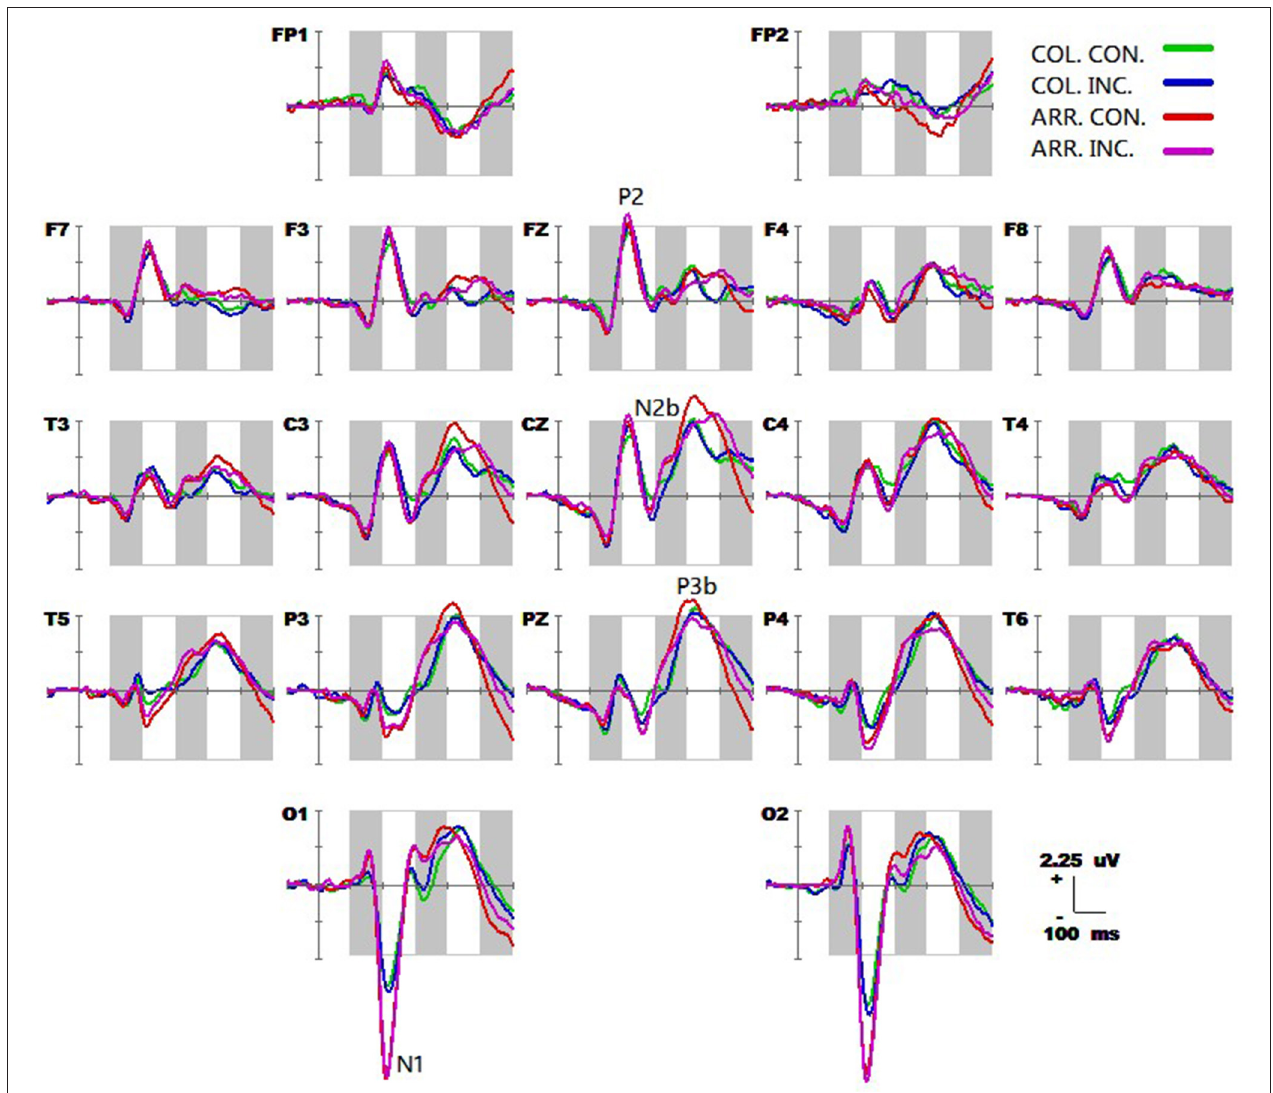
FIGURE 2 | Grand average event-related potential (ERP) waveforms (from − 100 to 600ms) are shown for 19 electrodes across all trial types, from the 25 subjects. The green, blue, red, and purple traces correspond to group average ERP of the color-congruent, color-incongruent, arrow-congruent, and arrow-incongruent conditions, respectively. The baseline ERP measurement is the mean amplitude of a 100-ms pre-stimulus